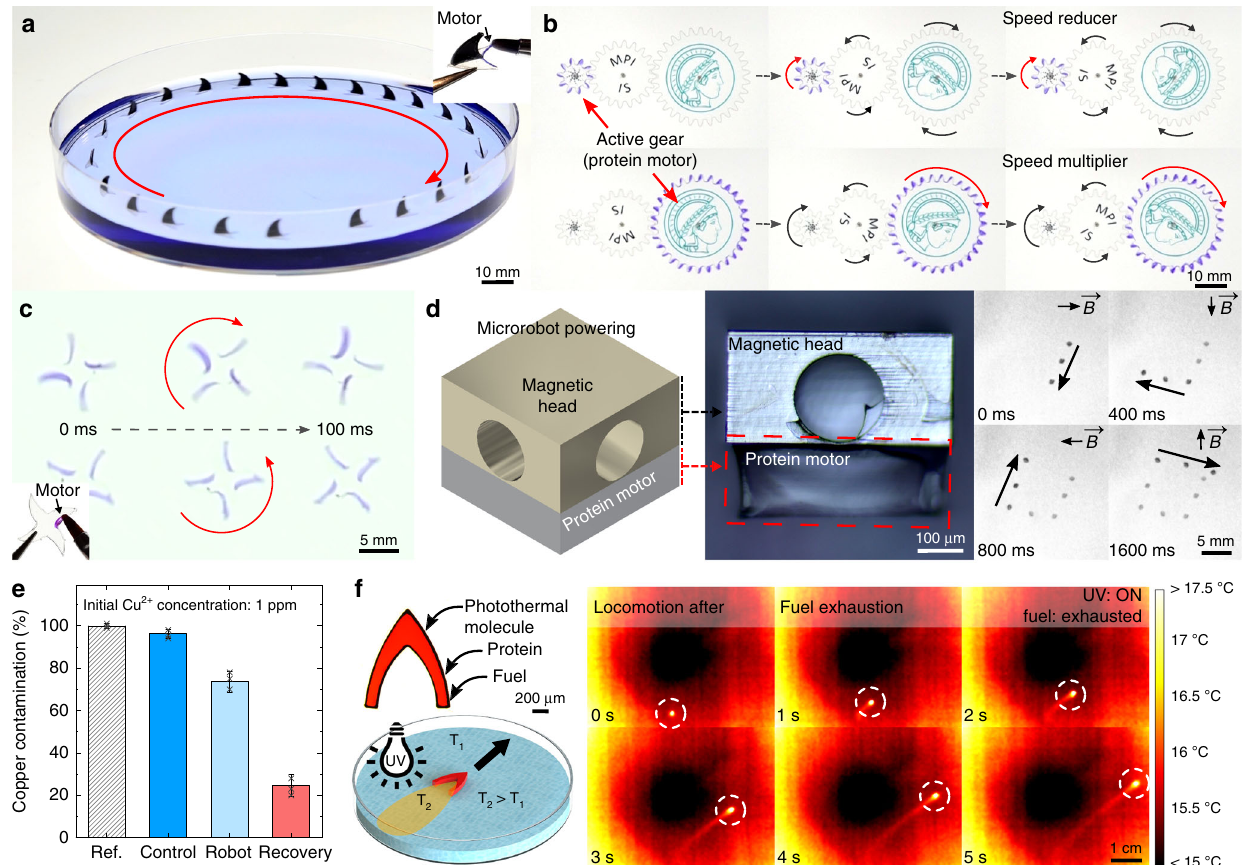
Fig. 6 Multifunctional protein motors. Modular motors: Protein coatings are applied to inanimate objects as integrated power sources for locomotion: a shark fi n swimmers, b autonomous gear trains (reducer and multiplier), c spinning rotors, and d magnetic microrobots with programmable complex locomotion (arrows show the direction of the magnetic fi eld ~ B ). e Environmental remediation. Single protein motor ( l = 10 mm) captures Cu 2 + contaminants from water. Metal ions can be recovered after treatment (error bars represent standard deviation, n = 3). f Locomotion after fuel exhaustion. Protein motors ( l = 1 mm) were doped with photothermal molecules. After the chemical fuel is exhausted, UV wide- fi eld illumination induces thermal Marangoni forces that propel the motor forward. Color scale represents temperature from 15 to 17.5